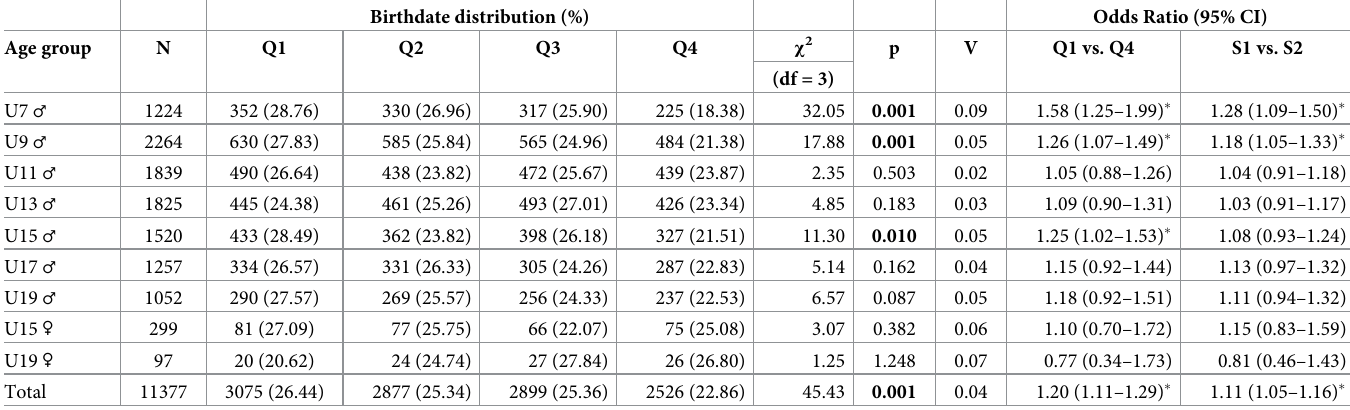
Table 2. Relative age effect analyses across age groups in Luxembourgish youth football.